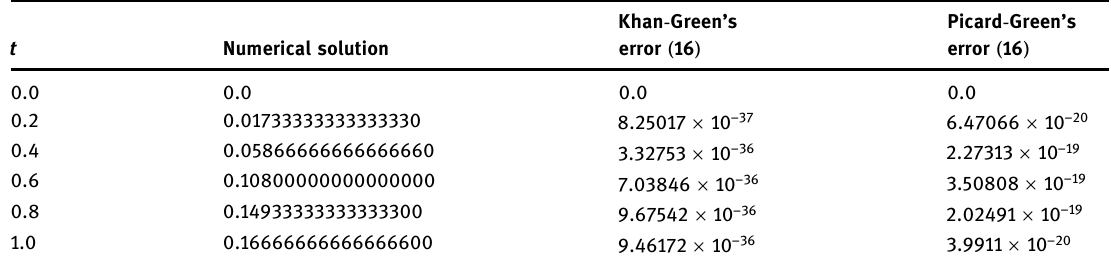
Table 5: Numerical results of Example 2 and comparison of Khan - Green ’ s and Picard - Green ’ s